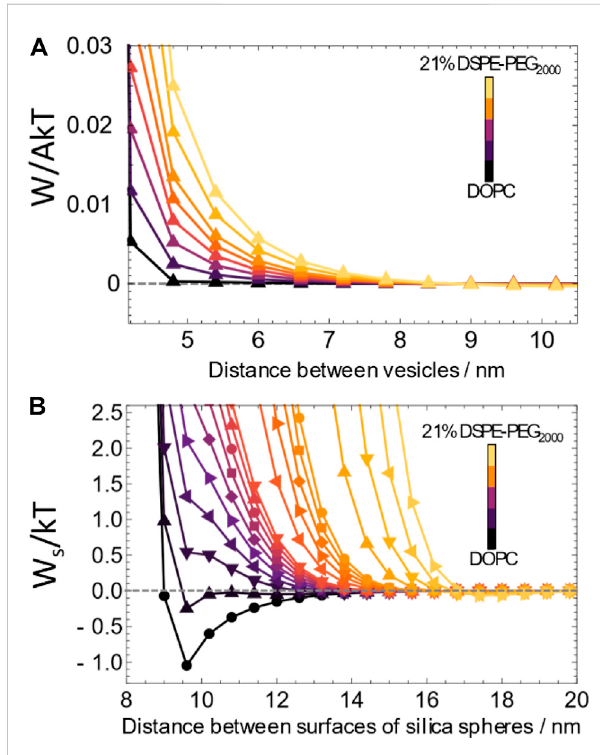
FIGURE 1 Predicted interaction strengthbetween (A) SUVs[perarea, A]and (B) CSLBs of DOPC with increasing amounts of DSPE-PEG 2000 . Negative W values indicate attraction and positive values indicate repulsion. Note — legend does not follow a linear